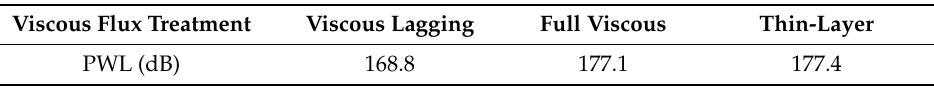
Table 3. Estimated acoustic power levels (dB) for three different viscous flux models according to source types. PWL: predicted acoustic power